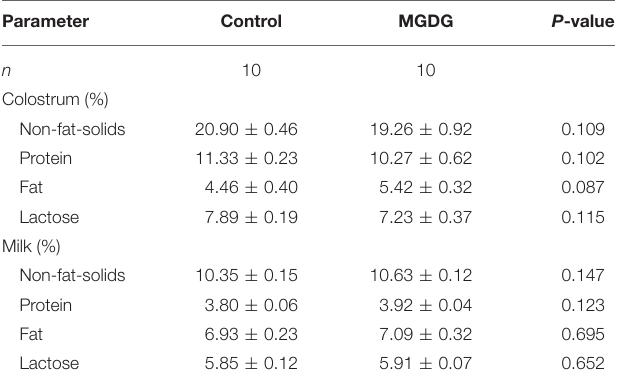
A P < 0.05 indicates the existence of a significant difference among treatments.